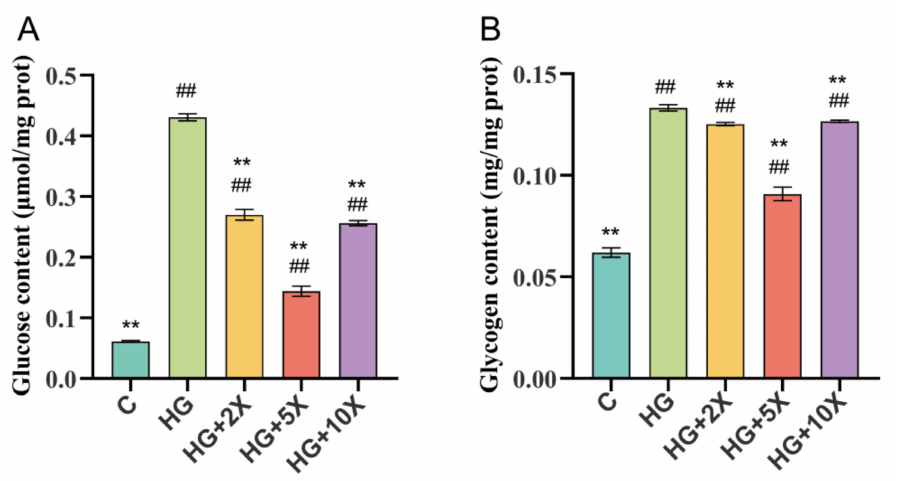
Figure 2. Effect of supplementation with A. muciniphila cell-free supernatant on glucose and glycogen content in C. elegans . ( A ) Glucose content; ( B ) glycogen content. Results are expressed as mean ± SD deviation, and p -values are calculated by Tukey’s test. Compared with the control group, ## is significantly different at p < 0.01; compared with the high-glucose group, ** is significantly different at p < 0.01.